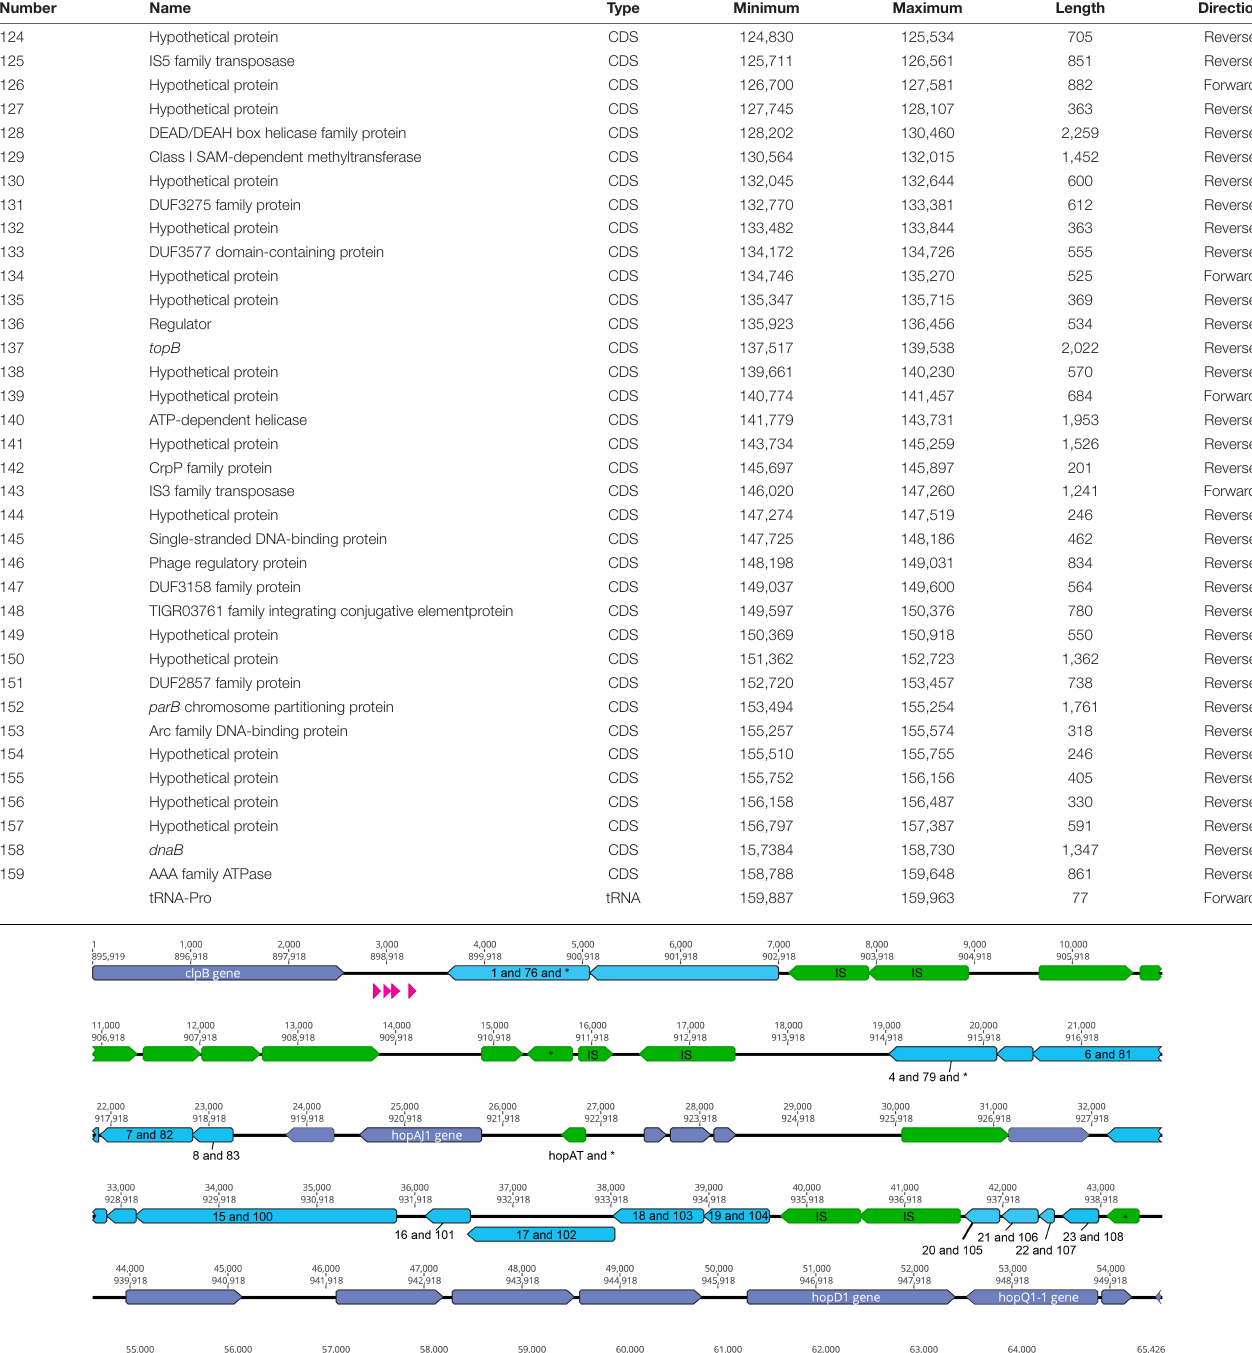
Frontiers in Microbiology |